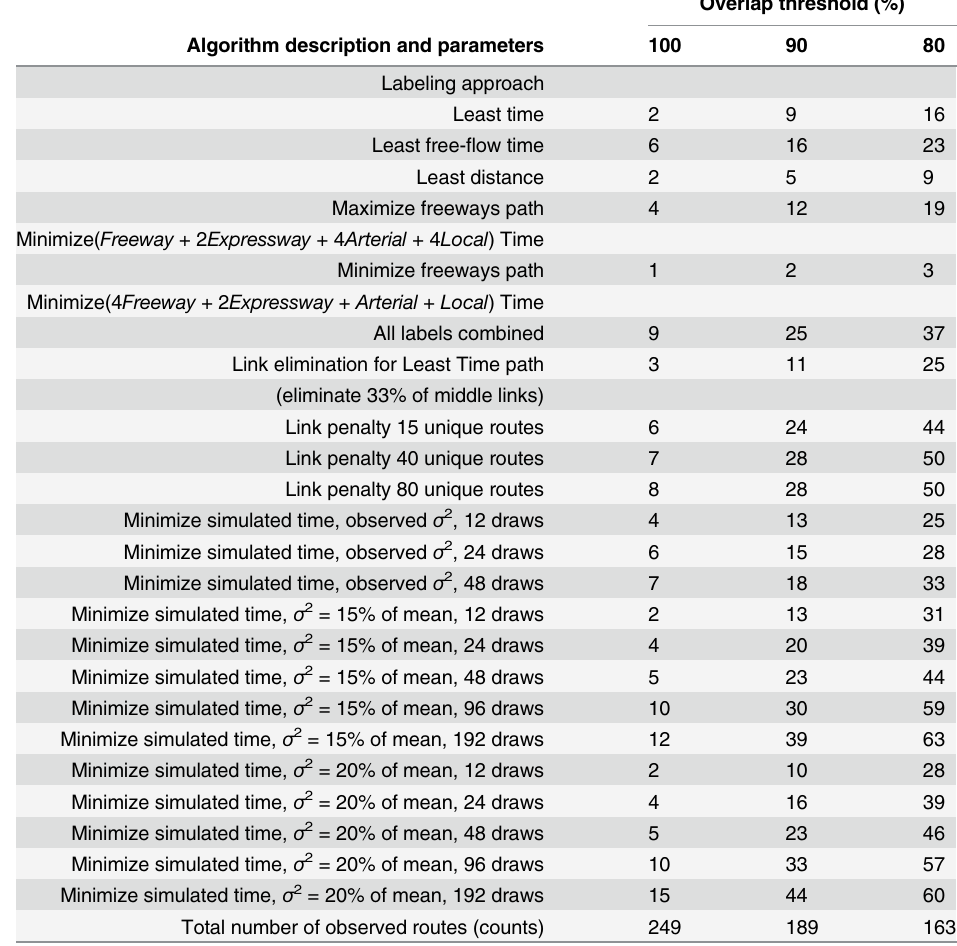
Table 1. Coverage: Percentage of generated routes which are observed using alternative route choice set generation algorithms based on GPS data and Twin Cities regional planning network. Overlap threshold (%) Algorithm description and parameters